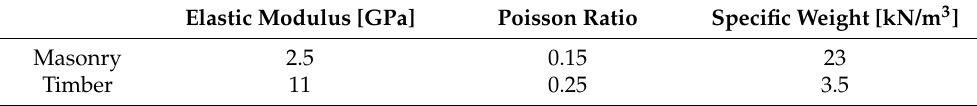
Table 2. Material